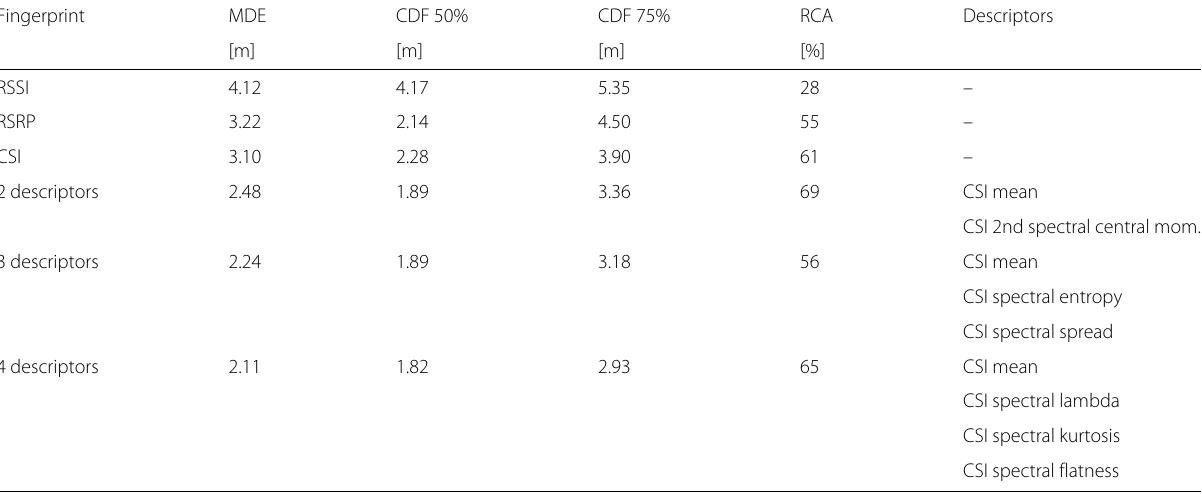
Table 5 Comparison of signal fingerprinting approaches based on RSSI, RSRP, CSI vectors, and RSRP/CSI descriptors (1 cell, 50 RBs)